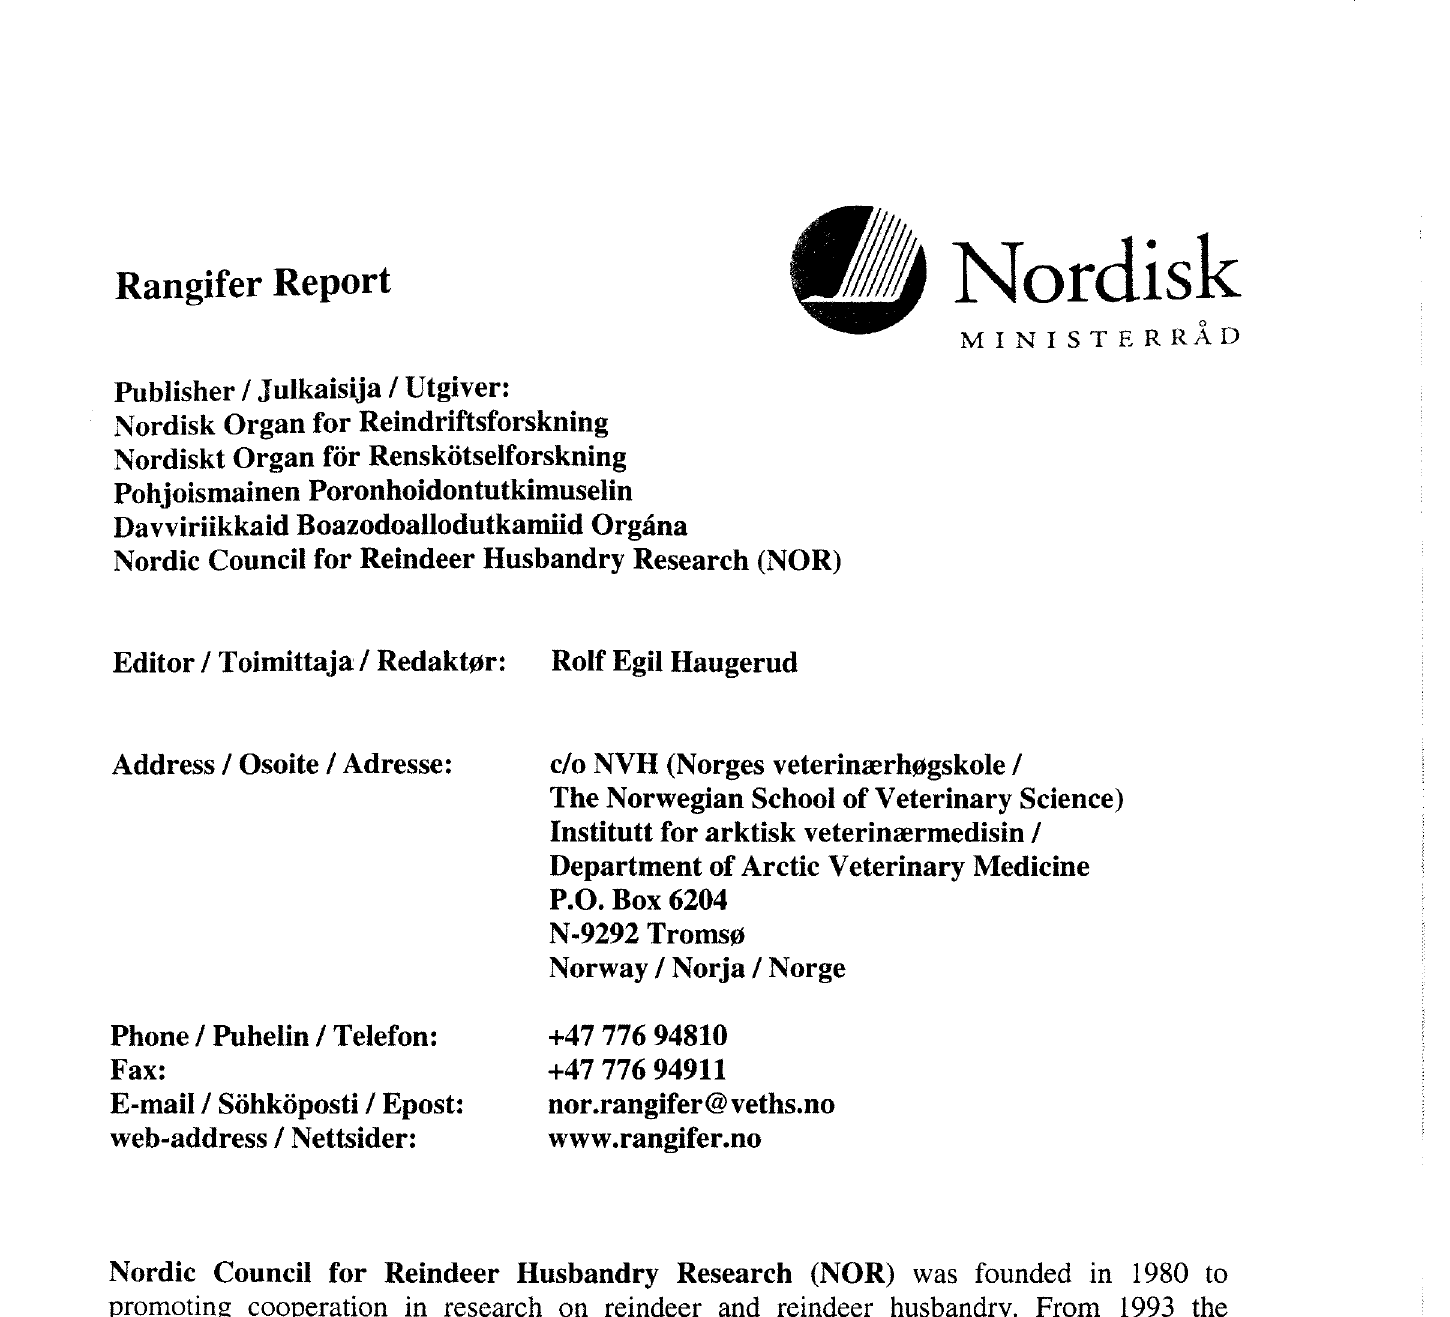
(NOR) ble etablert i 1980 og har vedtekter vedtatt av Nordisk Ministerråd i 2003. Organet er et samarbeidsorgan mellom Finland, Norge og Sverige med formål å fremme utvikling og samordning av rein- og reindriftsforskningen til nytte for reindriftsnæringen i de nordiske land. Virksomheten finansieres ved direkte bidrag fra